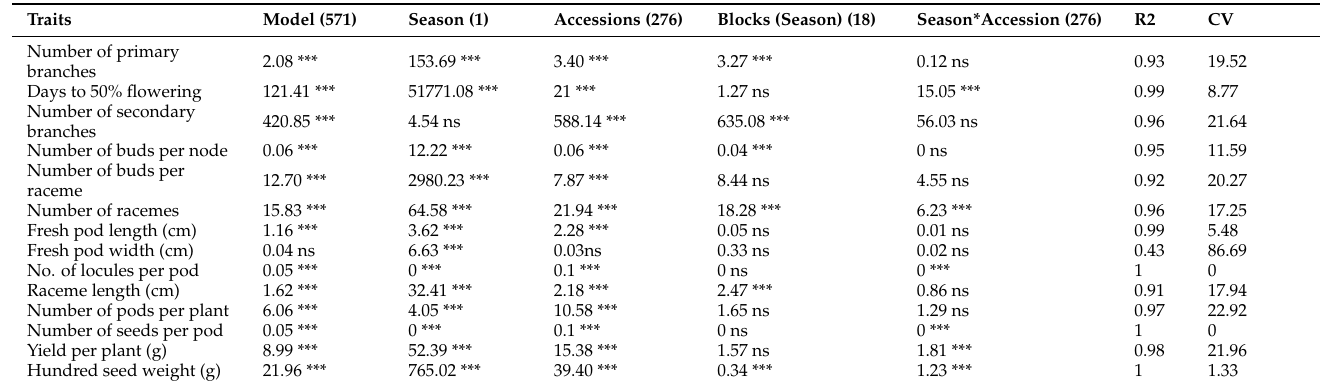
Table 2. Mean squares from ANOVA for 14 quantitative traits of lablab across two cropping seasons in Northern